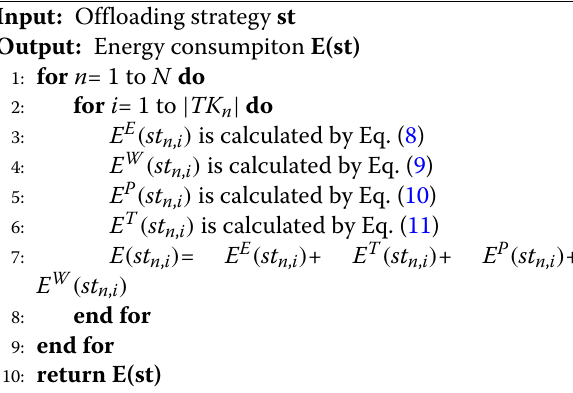
Algorithm 2 Energy consumption calculation